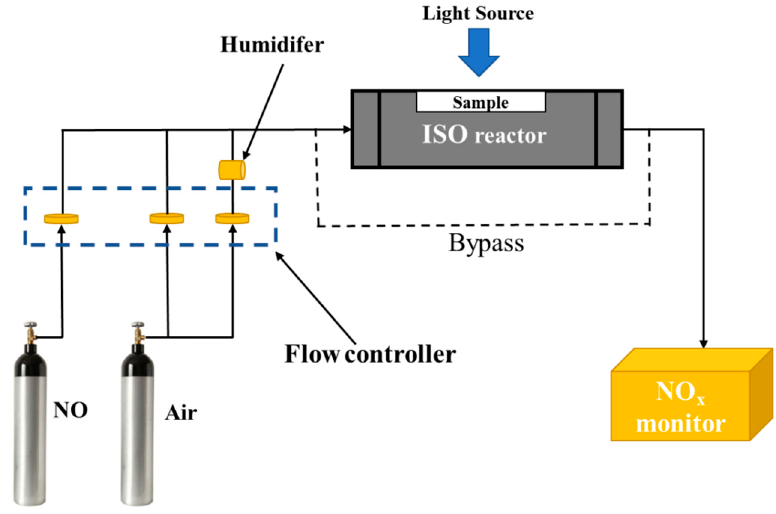
Figure 11. Schematic image for NO-NO 2 -NO x photocatalytic performance test and